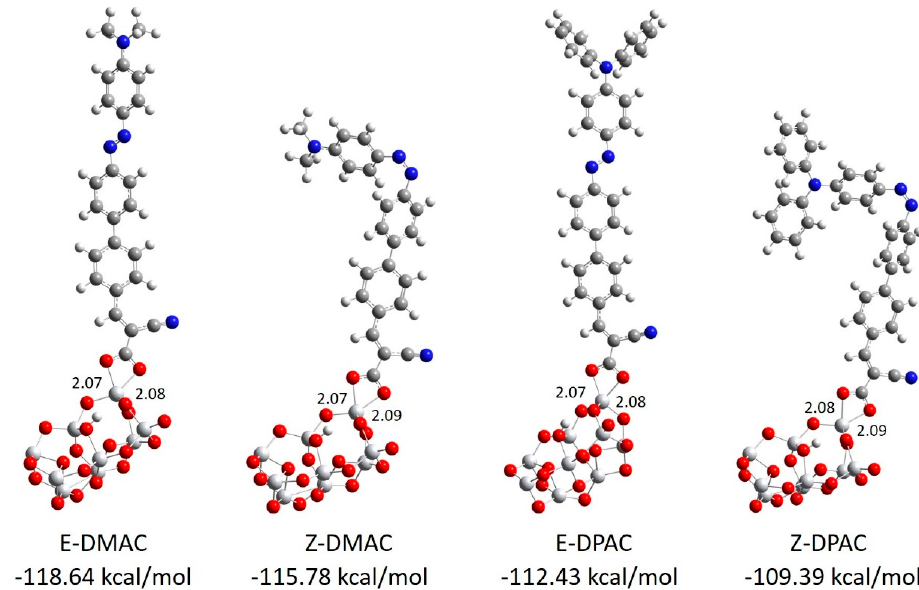
Figure 2. Optimized bidentate chelating mode and adsorption energies of DMAC and DPAC dyes on a (TiO 2 ) 9 anatase cluster calculated at the B3LYP level using the 6-31G(d,p) basis sets for non-metals and LANL2DZ basis sets with ECP for the Ti